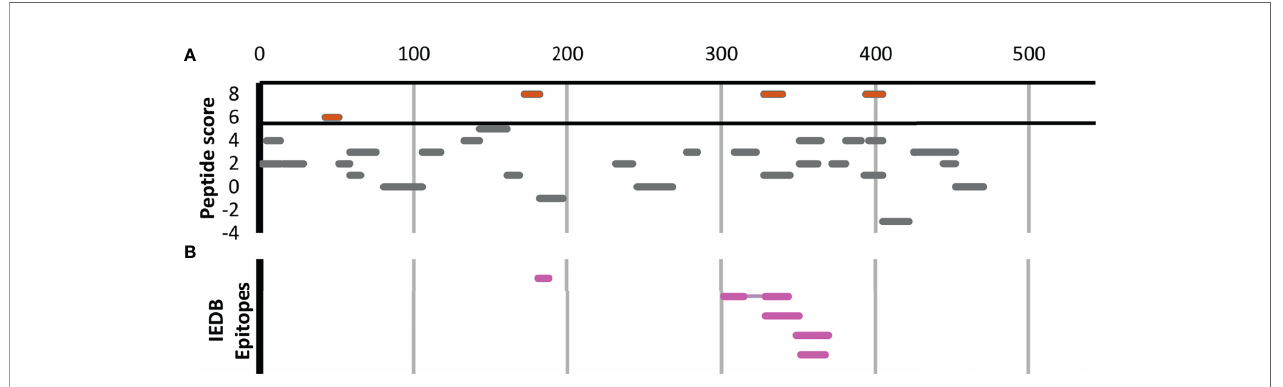
FIGURE 4 | The 32 F. tularensis GroL peptides detected in at least two Experiment samples. Horizontal line segments indicate the position of each peptide along the length of the 544aa GroL protein sequence. (A) Peptide enrichment score based on our proteomics results, with a score of 8 indicating that the peptide was found in greater abundance in all 8 Experiment samples relative to their respective Control samples. The threshold for inclusion in Table 1 was a score of ≥ 6 or better (shown in red). (B) Five B-cell epitopes identi fi ed by DXMS by Lu et al. (39), including one